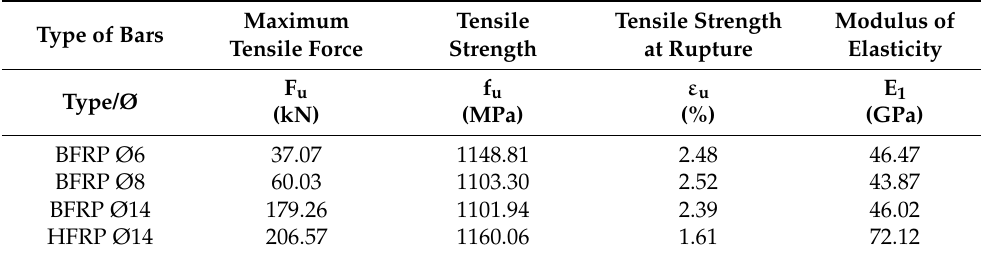
Table 4. Mechanical properties of FRP